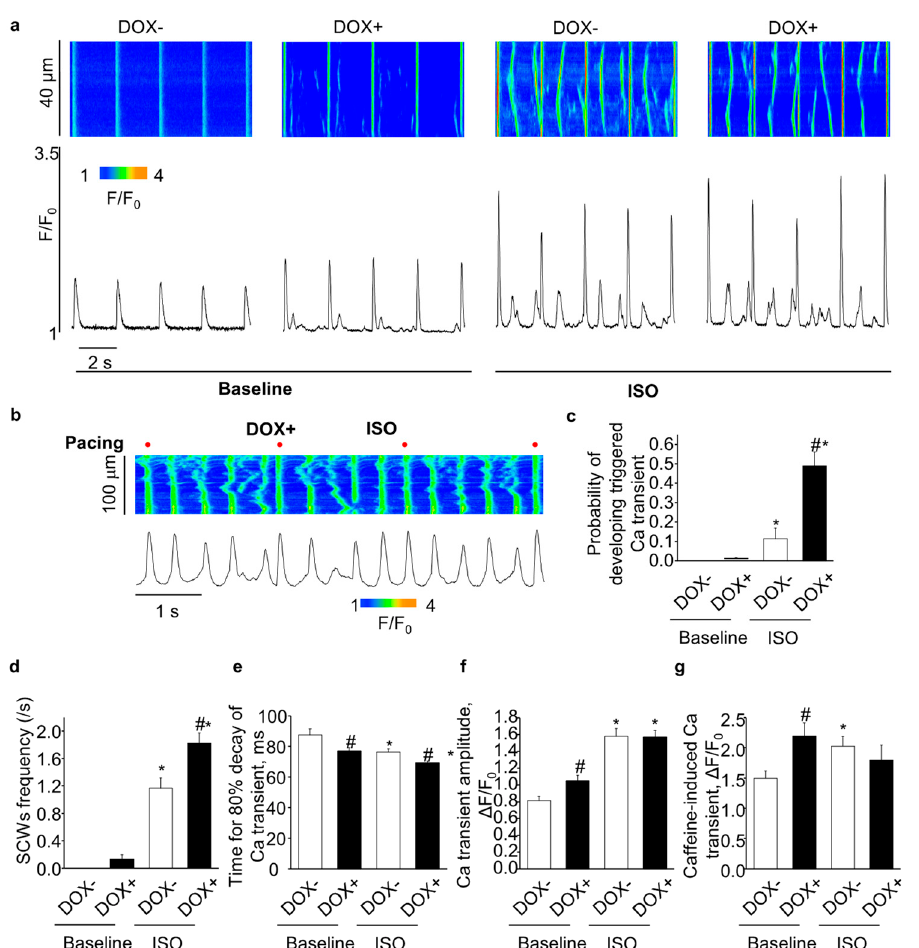
Figure 5. The effect of acute SERCA2a overexpression on Ca handling in intact CASQ2 KO atrial myocytes paced at 0.5Hz. ( a ) representative line-scan images (top) and time-dependent profiles (bottom) of spontaneous Ca waves (SCWs) at baseline and in the presence of 100 nM ISO; ( b ) example of triggered Ca transient in DOX+ atrial myocytes, in the presence of ISO. Electrical stimulation is indicated by the red dot labeling. ( c ) the probability of the cells developing triggered Ca transient; ( d ) the summary of frequency of SCW; ( e ) the kinetics of 80% Ca transient decay; ( f ) amplitude of Ca transients; ( g ) amplitude of caffeine-induced Ca transients. * p < 0.05 vs. baseline, # p < 0.05 vs. DOX − .